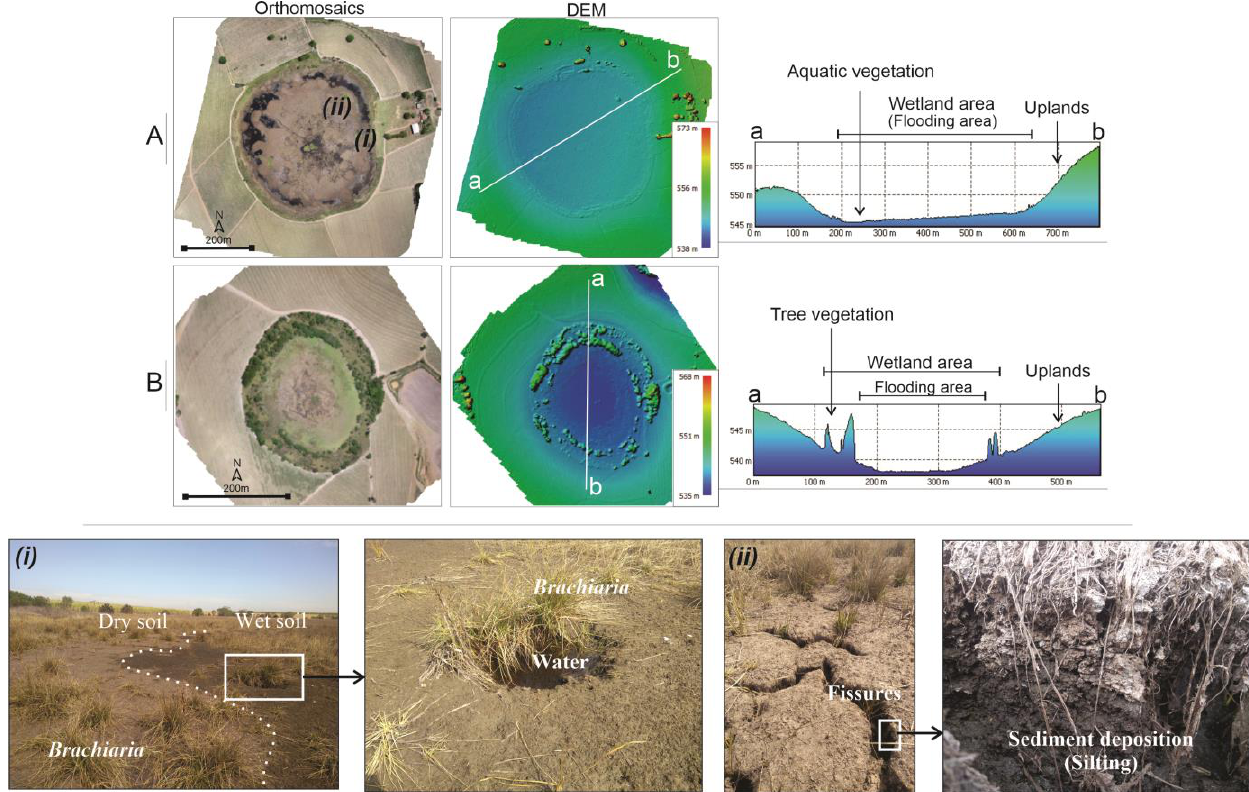
Figure 5. October-2019 orthomosaics, digital elevation models, and elevation profiles (ab) of the two wetlands, A and B. ( A ) Wetland with perennial flooding and no tree vegetation, perimeter of 1485.1 m; ( B ) Wetland with temporary flooding and tree vegetation on its limits, perimeter of 972.3 m. Wetland A is approximately 34% bigger than B. Table 2. Wetland A and B photogrammetric calculations